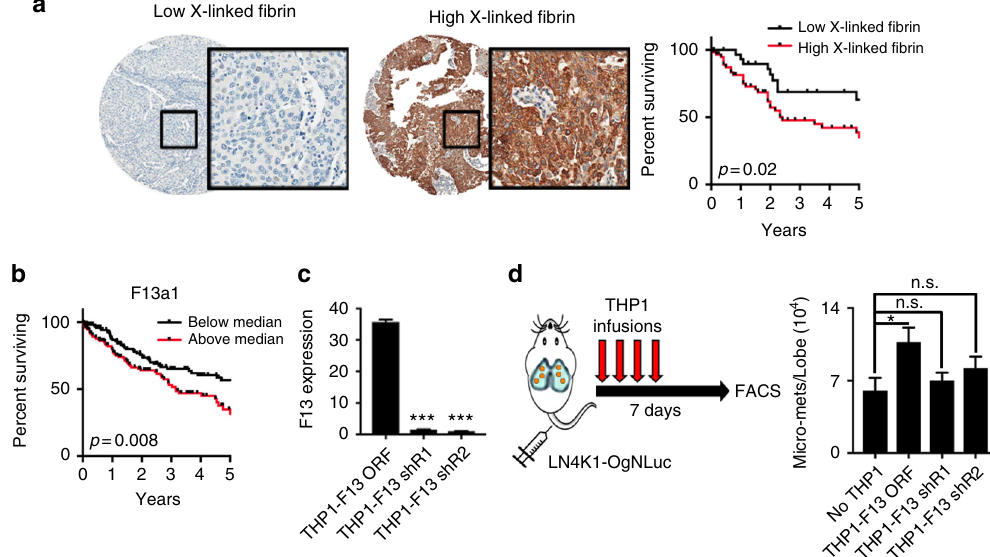
Fig. 7 FXIIIA and fi brin cross-linking is associated with LUSC progression. a Representative IHC images (left) of tumors from the LUSC tissue microarray with low or high cross-linked fi brin ( n = 96 patients). Kaplan-Meier plot of recurrent-free survival following surgical resection. P -values were obtained with the log-rank test. b Kaplan – Meier plot of overall survival in LUSC patients split by median expression levels of F13a1. P -values were obtained with the log- rank test. c Relative expression levels of F13a1 in THP1 monocytes stably expressing either F13 ORF or shRNAs against F13a1. P -values were obtained with Student ’ s t-test. d Schematic (left) and quanti fi cation of distant micro-metastases (right) following infusions of THP1 monocytes. NSG mice were injected via tail vein with LN4K1-OgNLuc cells on Day 1, followed by daily infusions of THP1 cells in the respective groups for Days 1 – 4. Mice were necropsied on Day 7, lungs were dissociated and FACS analysis performed for EpCAM + cells to quantify micro-metastases per lobe. Data are averages± s.e.m. P -values were obtained with Student ’ s t-test, n = 3 mice/group. n.s. = non-signi fi cant, * P < 0.05, *** P < 0.001